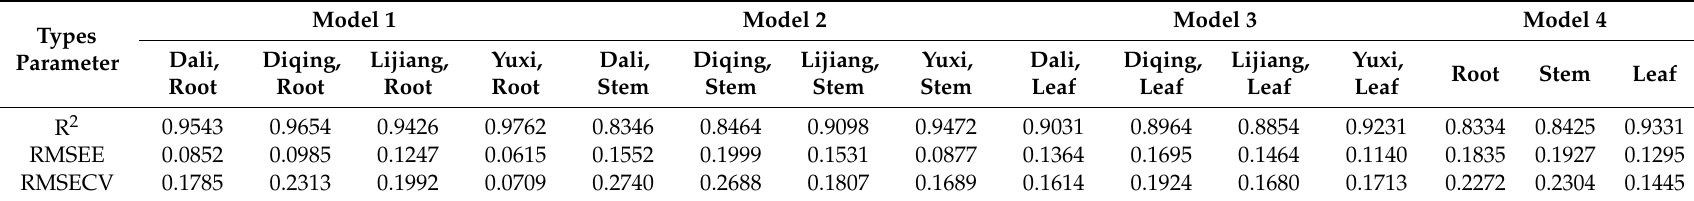
Table 1. Statistics of the optimal calibration models.